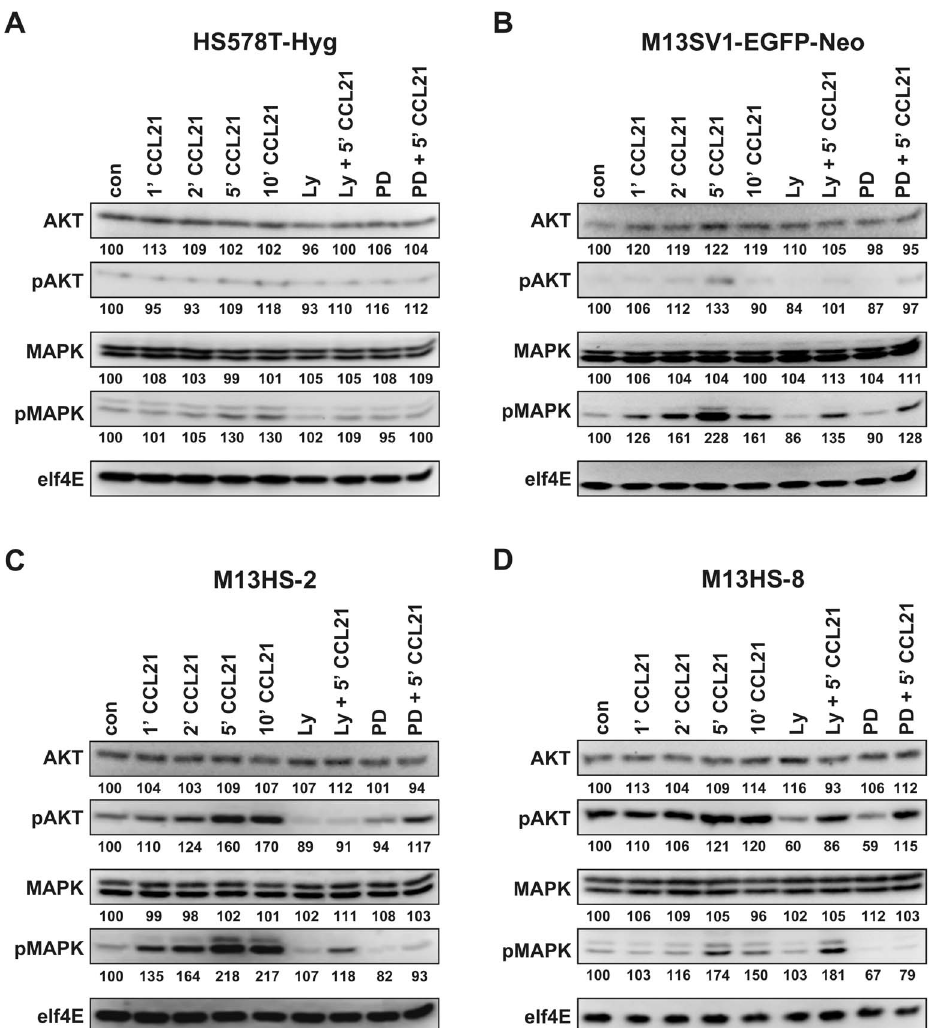
Figure 2. Analysis of signal transduction cascades initiated by CCL21/CCR7 signaling. Cells were treated with 500 ng/ml CCL21 for 0, 1, 2, 5, and 10 minutes. For inhibitor studies cells were preincubated for 60 minutes with 500 nM Ly29004 or 30 minutes with 500 nM PD98059, respectively. Cells were analyzed for AKT phosphorylation and MAPK p42/44 (MAPK) phosphorylation, whereby elf4E was used as a housekeeping gene. Values indicate the relative intensities of proteins in relation to elf4E, which was set to 100%. Shown are representative Western Blot data of n=3 independent experiments. (A) HS578T-Hyg breast cancer cells, (B) M13SV1-EGFP-Neo breast epithelial cells exhibiting stem cell characteristics, (C) M13HS-2 hybrid cells, (D) M13HS-8 hybrid